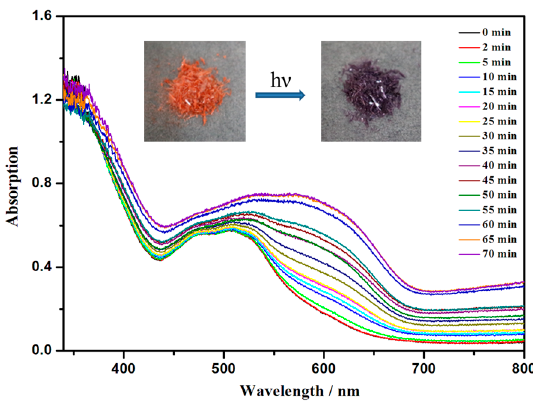
Figure 2. UV-vis diffuse-reflectance spectral changes of complex 1 upon Xenon lamp irradiation.